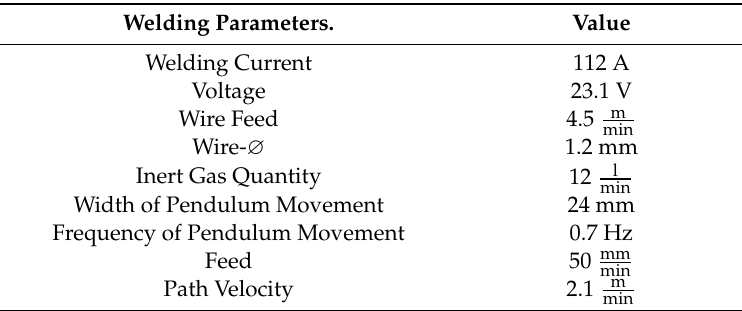
Figure 1. Wire arc additive manufacturing (WAAM) material: ( a ) semi-finished block products, ( b ) sampling plan for tensile specimens with directional designation related to the weld layers, ( c ) regions for micrographs (A and C), path for hardness measurements (B), and points for residual stress determinations (D1 to D3). Table 1. Parameters of the manufacturing process.